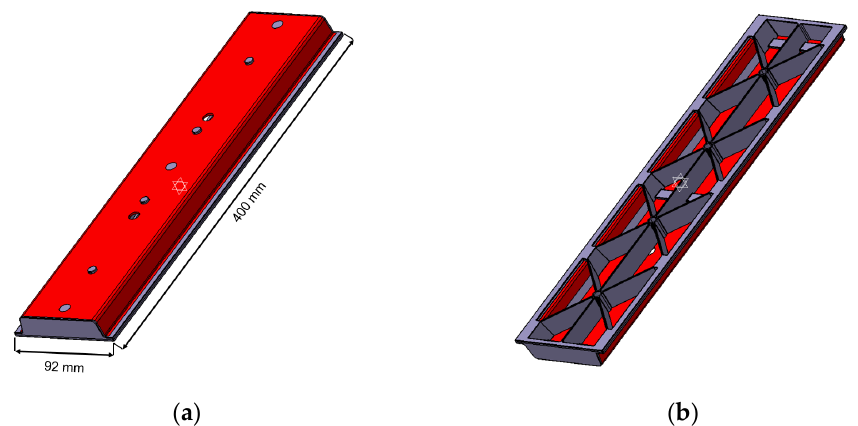
Figure 2. Geometry of the hybrid injection molded thermoplastic composite bending test structure with the PP/GF60 continuous fiber-reinforced thermoplastic composite in red and the PP/GF30 short fiber-reinforced thermoplastic composite in grey: ( a ) top and ( b ) bottom. Table 3. Labeling of the analyzed test specimen of the PP/GF30 short fiber-reinforced thermoplastic composites and the corresponding volume flow rate and orientation related to flow direction due to injection molding and sample preparation from test plates, respectively.